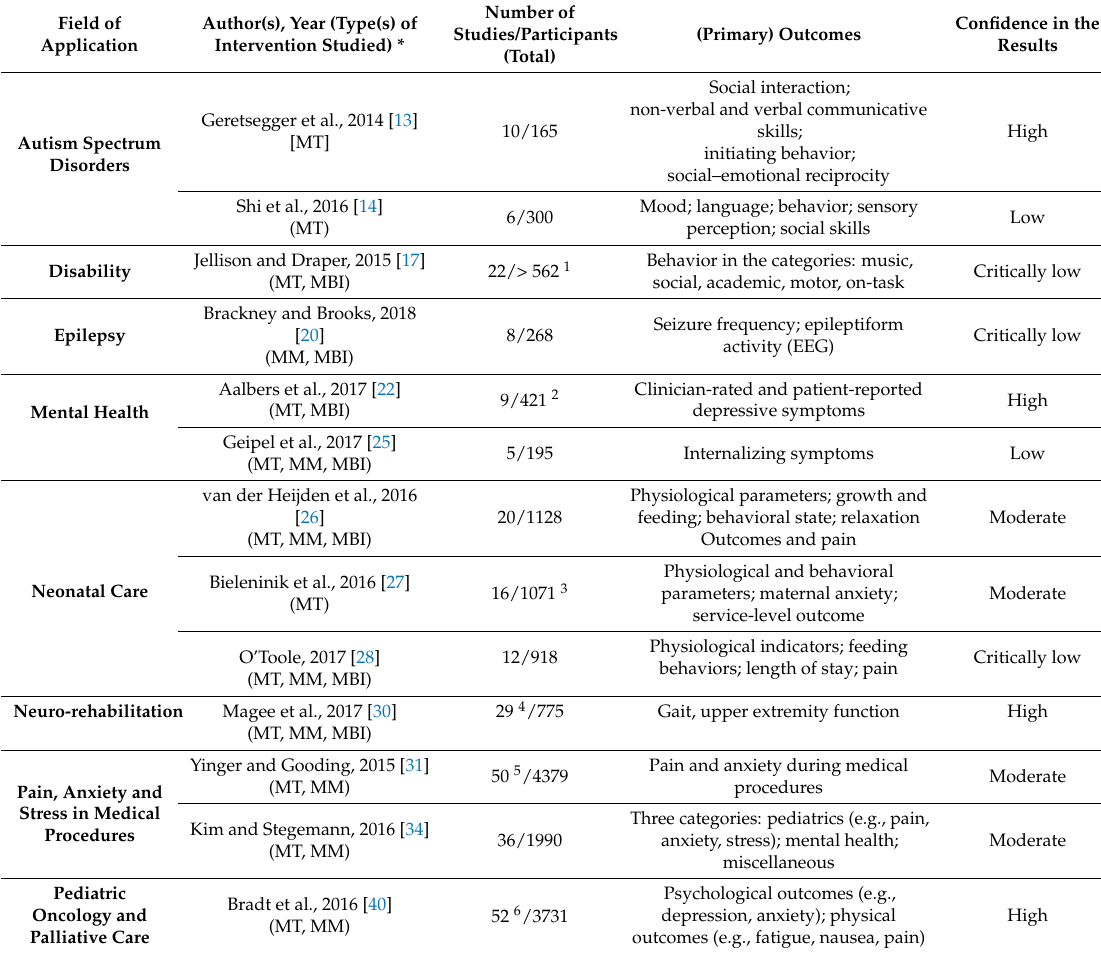
Table 1. Key characteristics and ratings of overall confidence in the results (based on AMSTAR 2) of included systematic